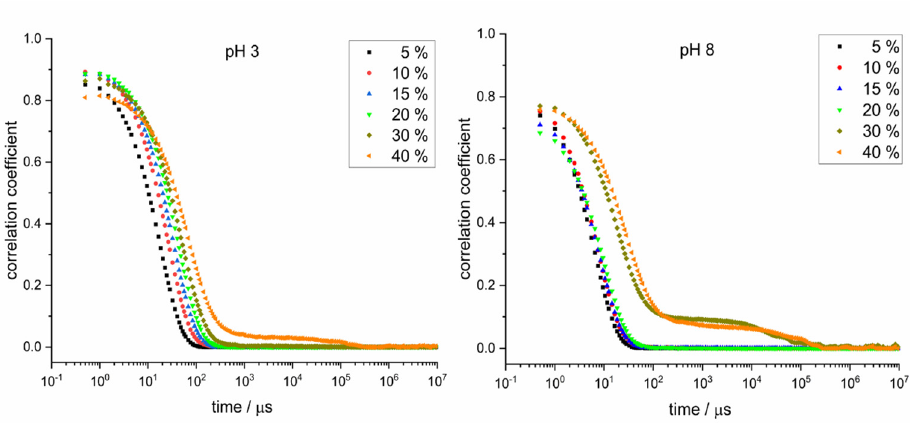
Figure 1. Correlograms of Sophorolipid (SL) in water at different concentrations (mass %) at left) pH 3 right) pH 8.